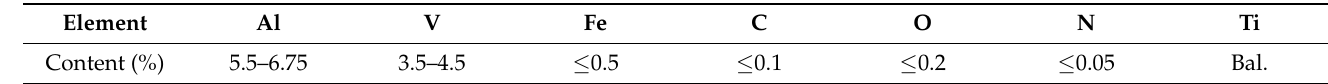
Table 1. The composition of Ti-6Al-4V